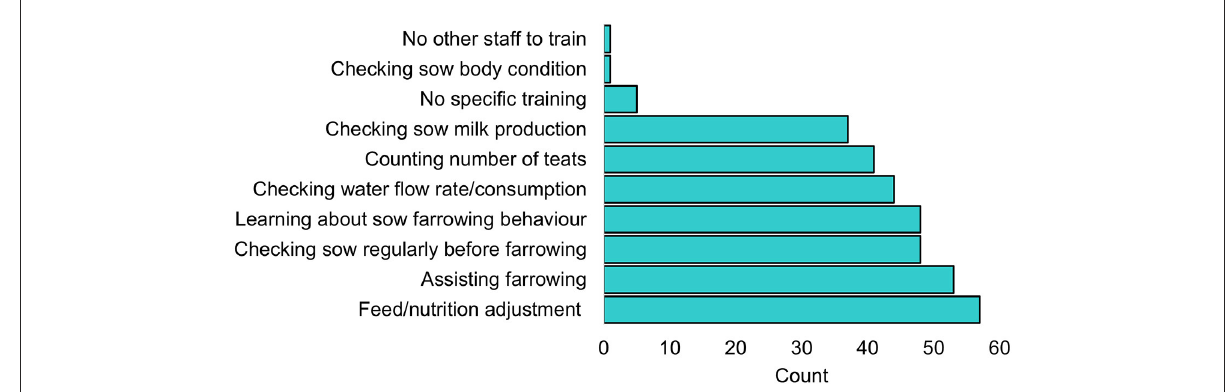
FIGURE4 Frequency of the reported selection of sow management training topics for farm